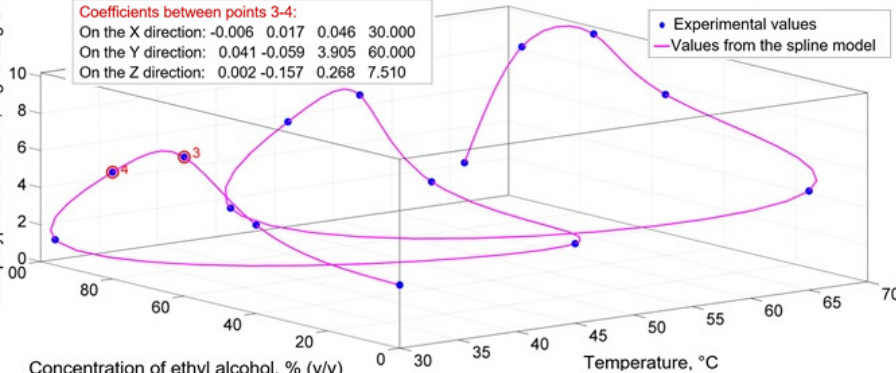
Figure 1. Mathematical model for the total content of polyphenols in grape marc extracts at different temperatures and concentrations of ethanolic solution, developed on cubic spline functions. Figure 2 shows the values of the four groups of coefficients of the cubic spline func- tions used for this mathematical model.